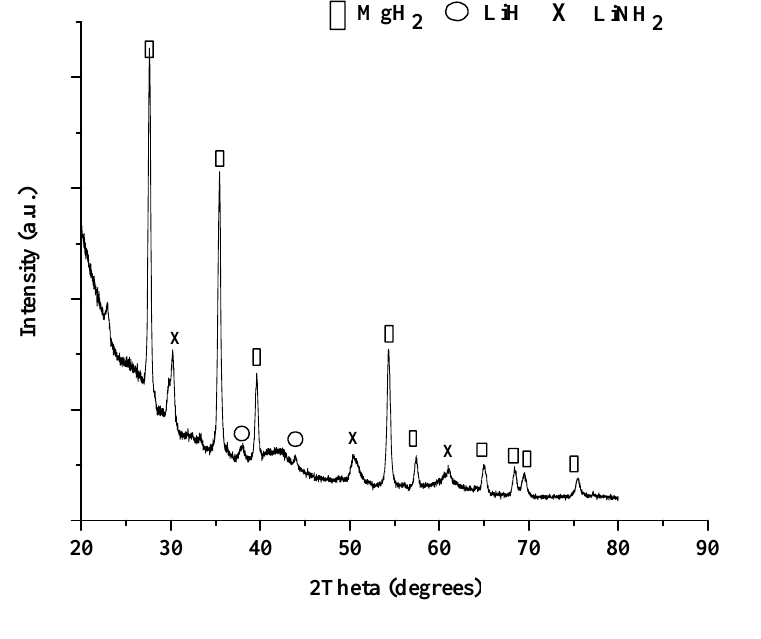
Figure 7. XRD pattern of starting material after heating to 200 °C under 100 bar of pressure prior to dehydrogenation